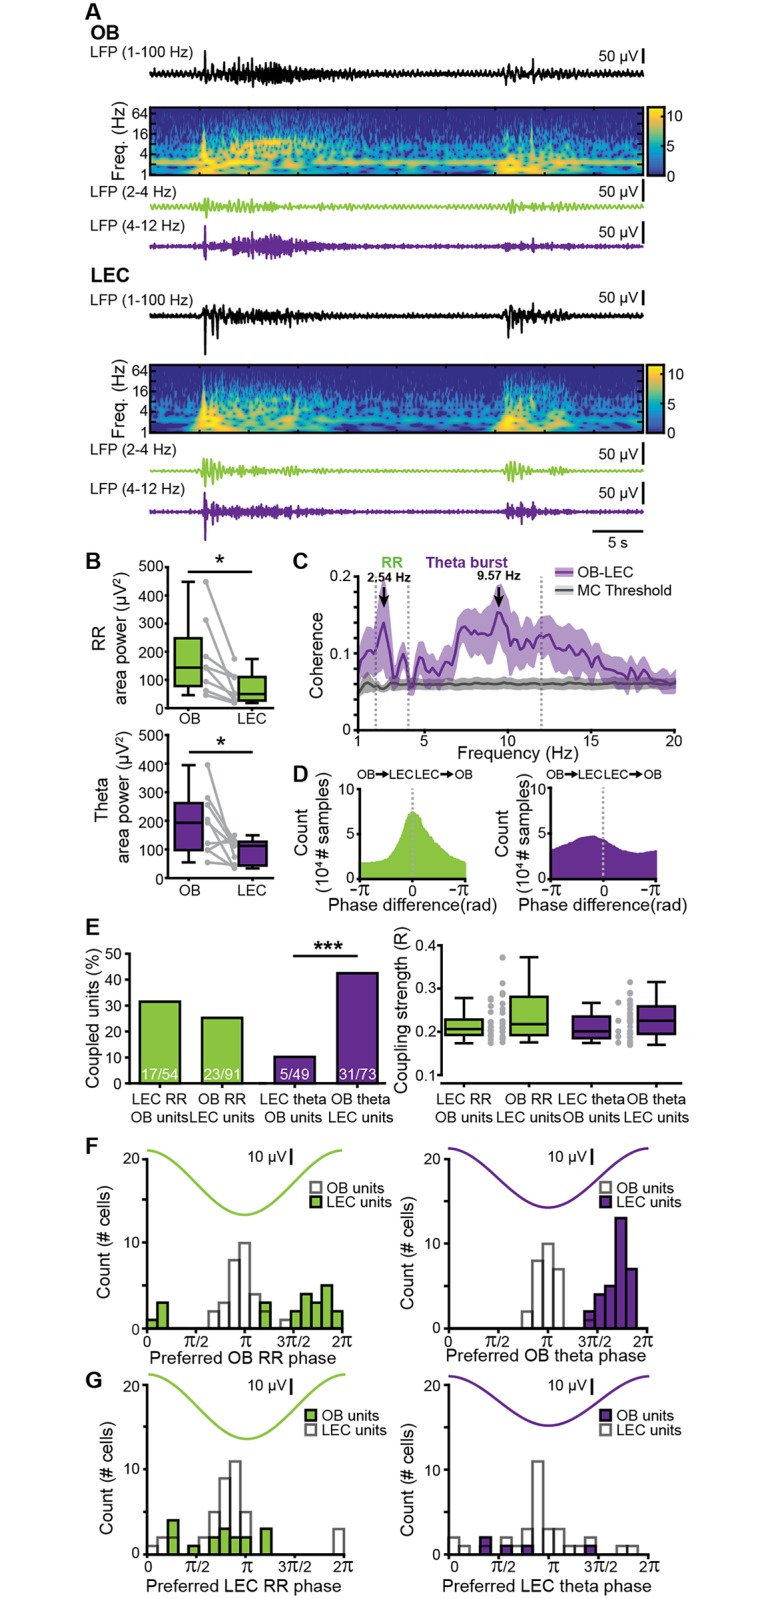
Frequency-dependent functional coupling between neonatal OB and LEC.(A) Characteristic traces of band-pass-filtered LFP recorded simultaneously in OB (top) and LEC (bottom) of a P9 mouse, displayed together with wavelet spectrograms showing the frequency (“Freq.”) content. Note the temporal correlation between discontinuous theta bursts in both areas. (B) Box plots displaying RR power (top, green) and theta burst power (bottom, purple) in OB and LEC. Gray lines and dots correspond to individual pups. (*p < 0.05, Wilcoxon signed-rank test). (C) Plot of imaginary part of coherence between OB and LEC showing prominent peaks in RR and theta band. The gray line corresponds to the significance threshold as assessed by Monte Carlo simulation. (D) Histograms of phase differences between RR (left, green) and theta (right, purple) activity recorded simultaneously in OB and LEC. (E) Left, bar diagram displaying the percentage of OB units coupled to the RR (green) and theta bursts (purple) in LEC and the percentage of LEC units coupled to the RR (green) and theta bursts (purple) in OB. Right, box plot showing the coupling strength of OB cells significantly locked to LEC oscillations (green: RR, purple: theta bursts) and of LEC cells significantly locked to OB oscillations (green: RR, purple: theta bursts). Gray dots correspond to individual cells (χ2 test of proportions, ***p < 0.001). (F) Histograms showing the distribution of preferred phases of LEC cells significantly locked to RR (left) and OB theta bursts (right) in neonatal OB. For comparison, histograms of OB cells locked to the respective OB rhythm are plotted as white bars. (G) Histograms showing the distribution of preferred phases of OB cells significantly locked to RR (left) and theta bursts (right) in neonatal LEC. For comparison, histograms of LEC cells locked to the respective LEC rhythm are plotted as white bars. Data are available in S1 Data. LEC, lateral entorhinal cortex; LFP, local field potential; MC, mitral cell; OB, olfactory bulb; P, postnatal day; RR, respiration-related rhythm.